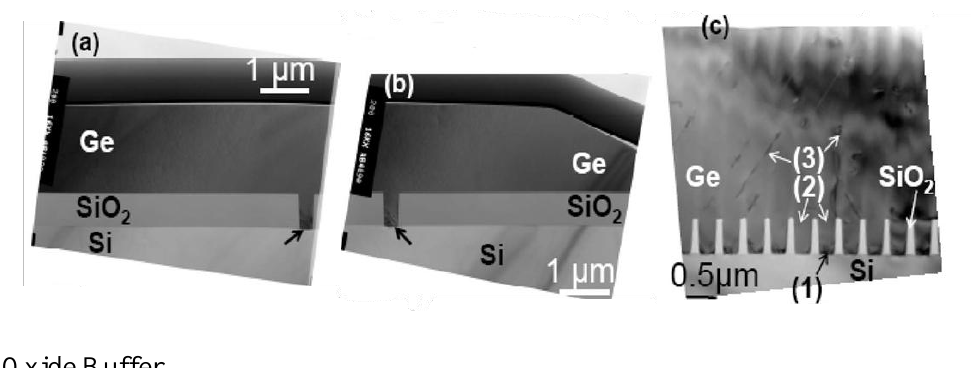
Figure 3. XTEM micrographs of Ge/Si heteroepitaxy using the ART method. ( a , b ) Uncoalesced Ge grown by epitaxial lateral overgrowth (ELO) from a single trench (indicated by a black arrow). The surface has been flattened using CMP; ( c ) ART Ge/Si in which growth from adjacent overgrown trenches has coalesced, reprinted with permission from [42]. Copyright 2009, The Electrochemical